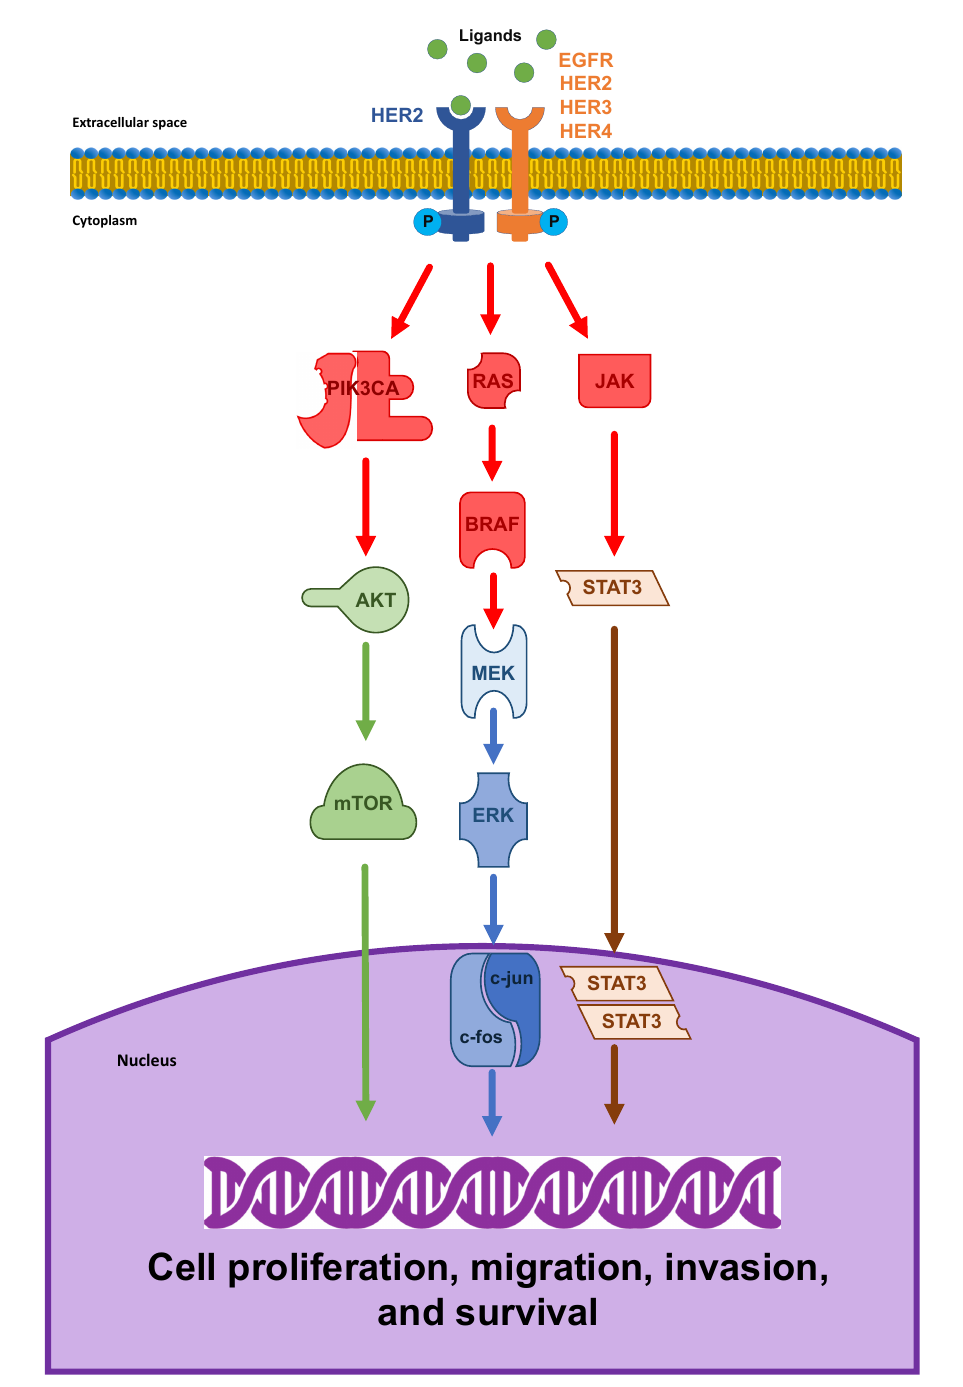
Figure 1. The HER2 pathway in tumorigenesis. Ligand binding to the extracellular domain of human epidermal growth factor receptor (HER2) stabilizes the dimerization between HER2 and another member of EGFR family receptors (EGFR, HER2, HER3, and HER4). By transphosphorylation of tyrosine residues within the cytoplasmic domains, the active homodimers or heterodimers thereafter stimulate several signaling cascades, such as the PI3K/AKT, the RAS/MAPK, and JAK/STAT pathways. These downstream pathways result in the transcription of genes driving tumor cell proliferation, migration, invasion, and survival.